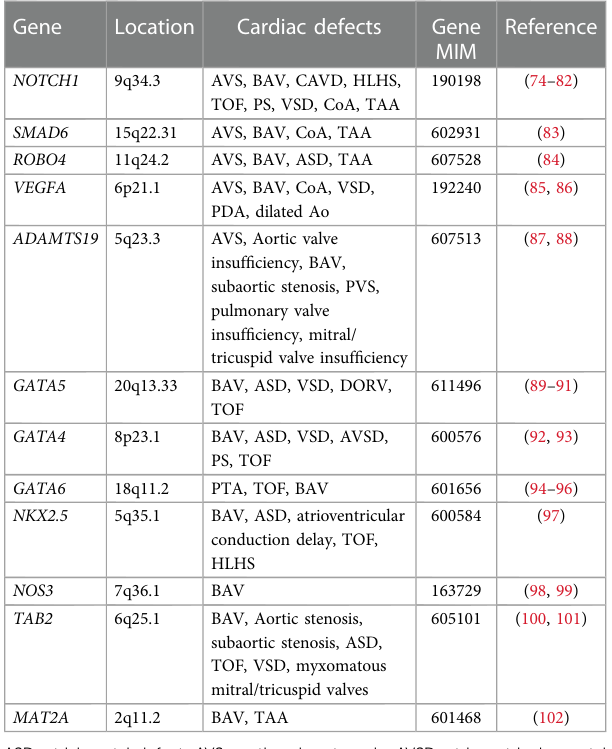
TABLE 2 Human genes associated with congenital aortic valve